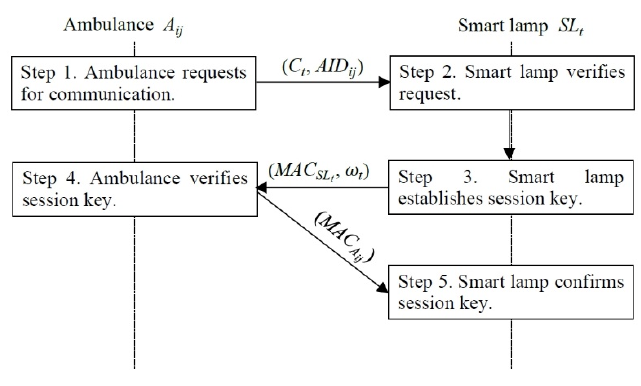
Figure 6. Secure ambulance communication phase.